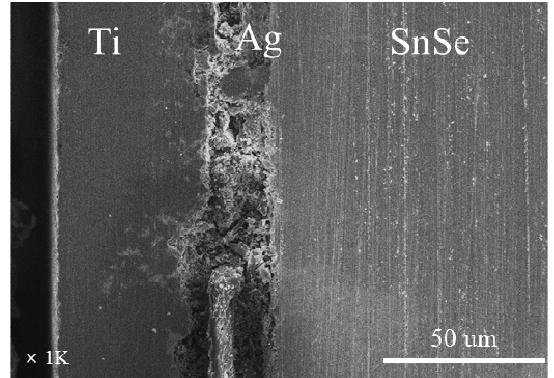
Figure 5. SEM image of Ag/Ti bi-layer metallization on SnSe.